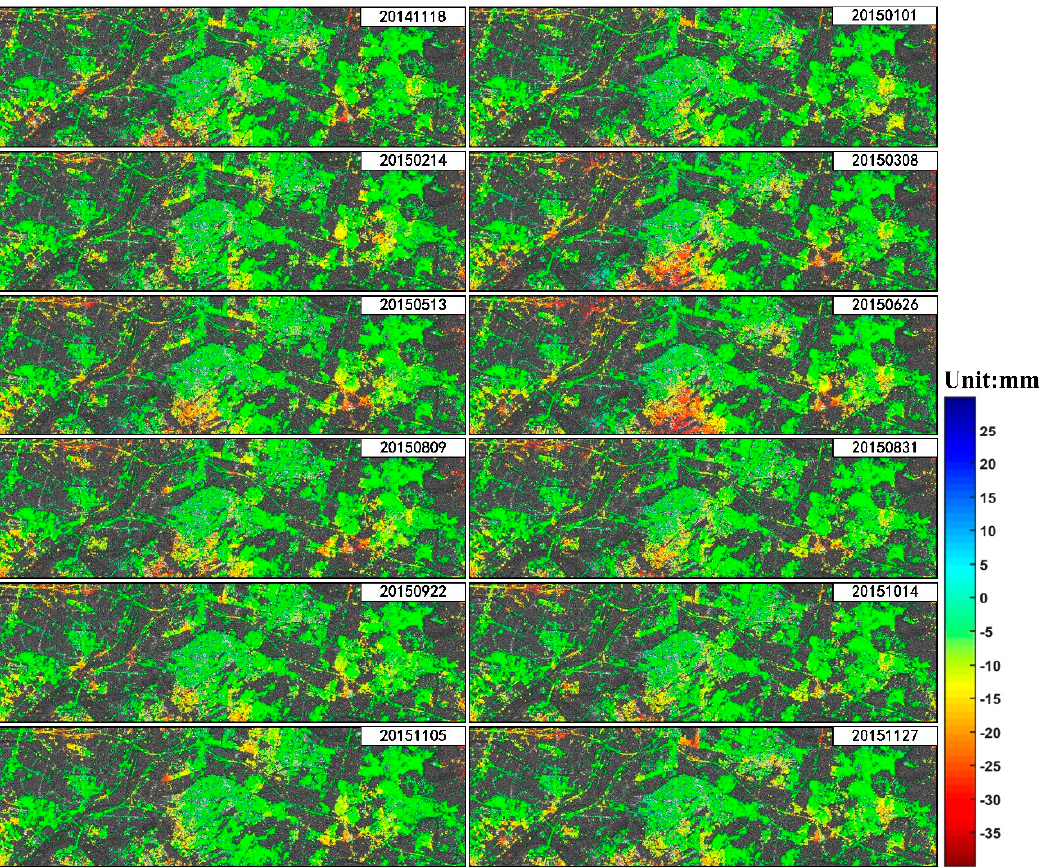
Figure 15. Time series deformation of G1501 Highway based on seasonal model (referenced to 27 October 2014).